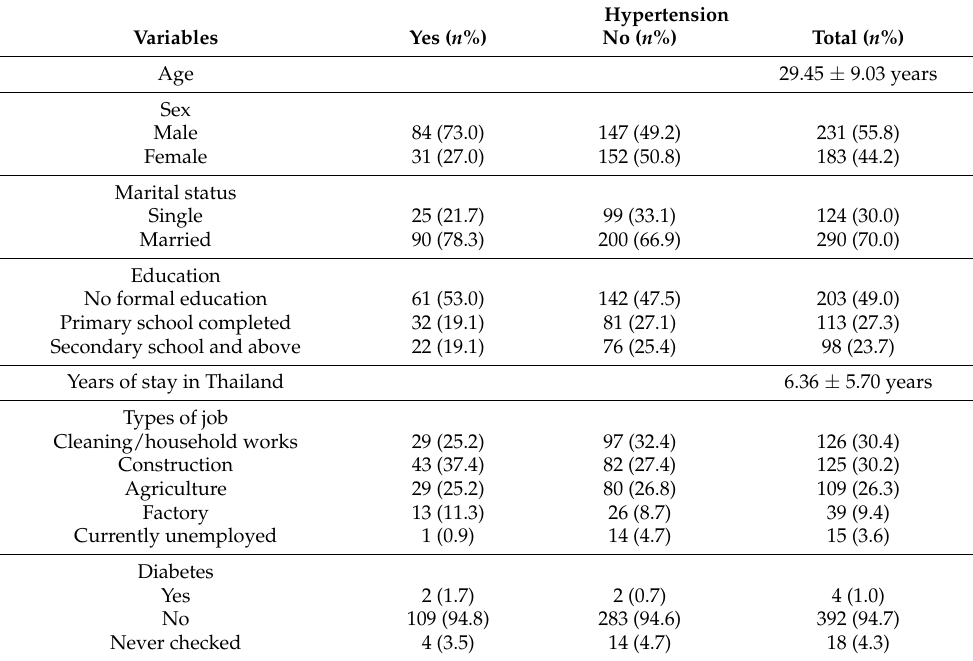
Table 1. Characteristics of the study participants ( n =